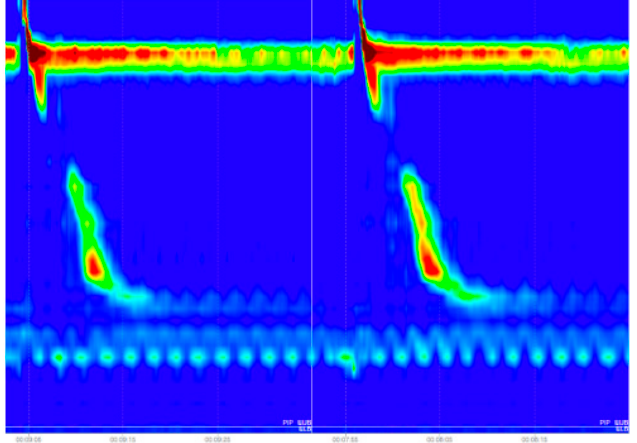
Figure 8. The left image depicts a week swallow, while the right image shows a fragmented contraction.